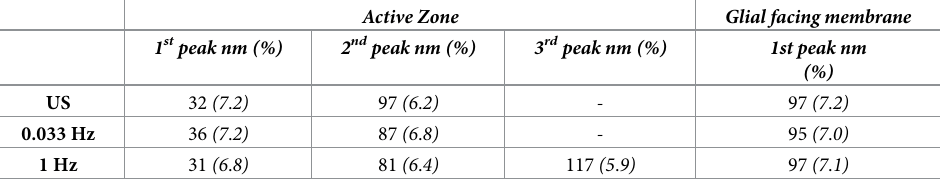
Table 1. Kernel distribution analysis of vesicle pools. Peak locations are stated in nm with the associated probability as a percentage determined from the probability density function